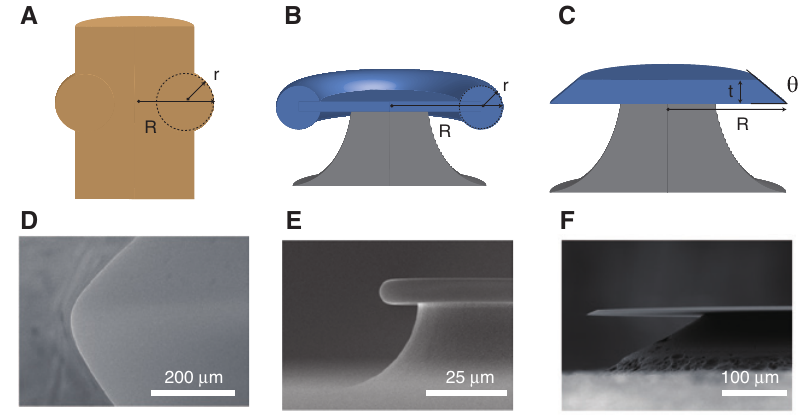
Figure 6: Modeling of resonator structure. (A) Spheroid (spherical) model, representing a mm-sized microresonator with a resonator radius R and a curvature radius r . (B) Microtoroid model, whose two structural parameters are major radius R and minor radius r . (C) Single-disk model with resonator radius R , thickness t , and wedge angle θ . (D–F) Scanning electron micrograph (SEM) images of WGM microresonators, (D) MgF microtoroid resonator, and (F) Silica microdisk